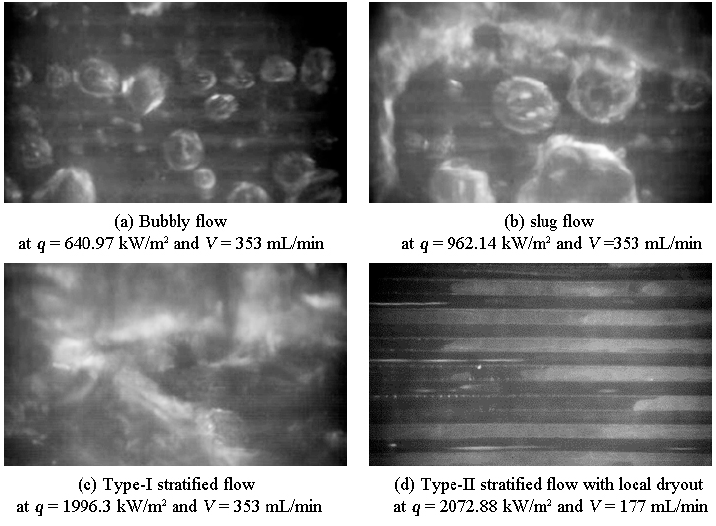
Figure 5. Flow patterns in NMC.